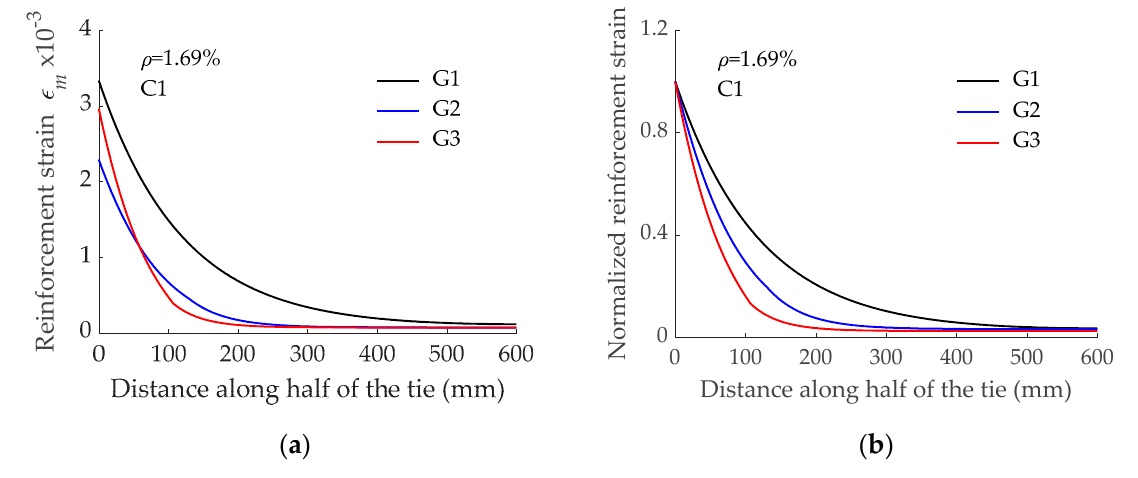
Figure 6. Effect of GFRP reinforcing bar surface configuration on: ( a ) Reinforcement strain distribution; ( b ) Normalized reinforcement strain distribution.